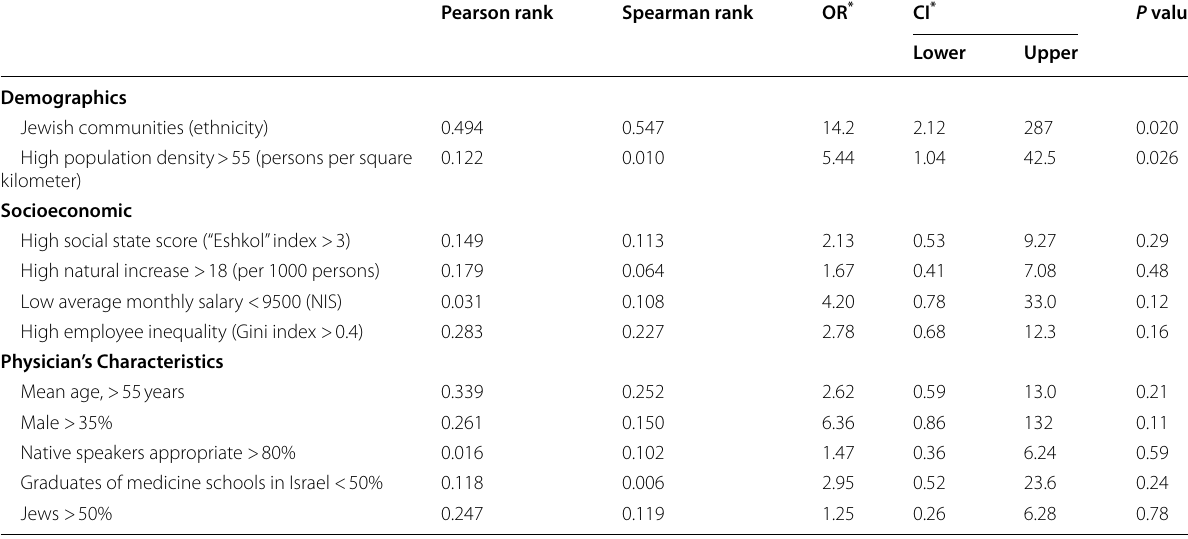
SMR standardized mortality ratio, OR odds ratio, CI confidence interval, NIS New Israeli Shekel * Uni-variable logistic regression model result; the outcome is high-rate female-to-male ratio (cutoff, 3.0). It presents municipality-related characteristics associated with equal or higher than average female-to-male